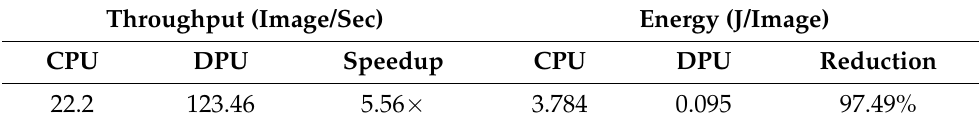
Table 8. Compression Engine Performance on CPU vs. DPU.